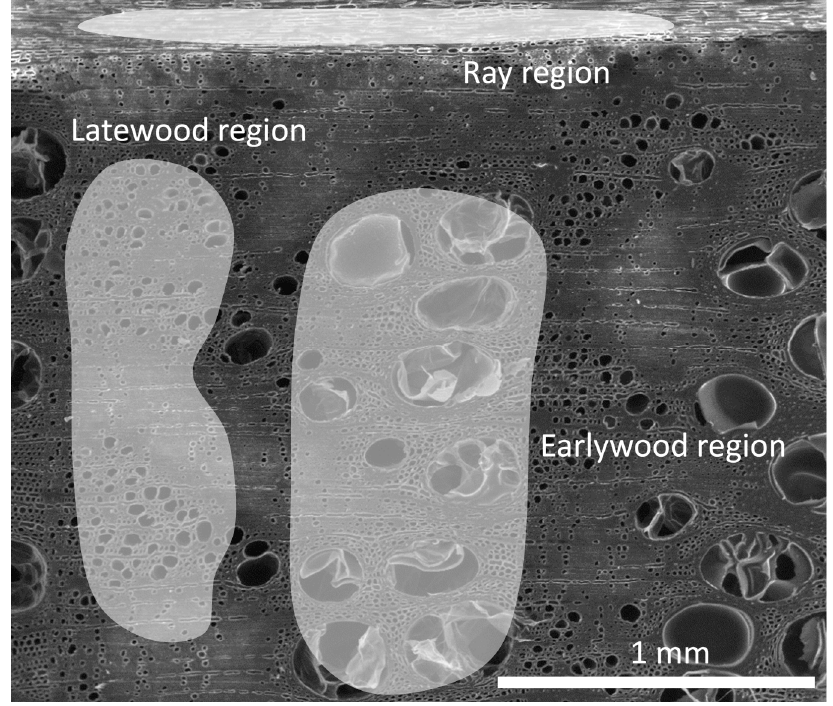
Figure 8. EDX area-measurements in the areas wood ray, late wood and early wood of a PEG-silane treated specimen.